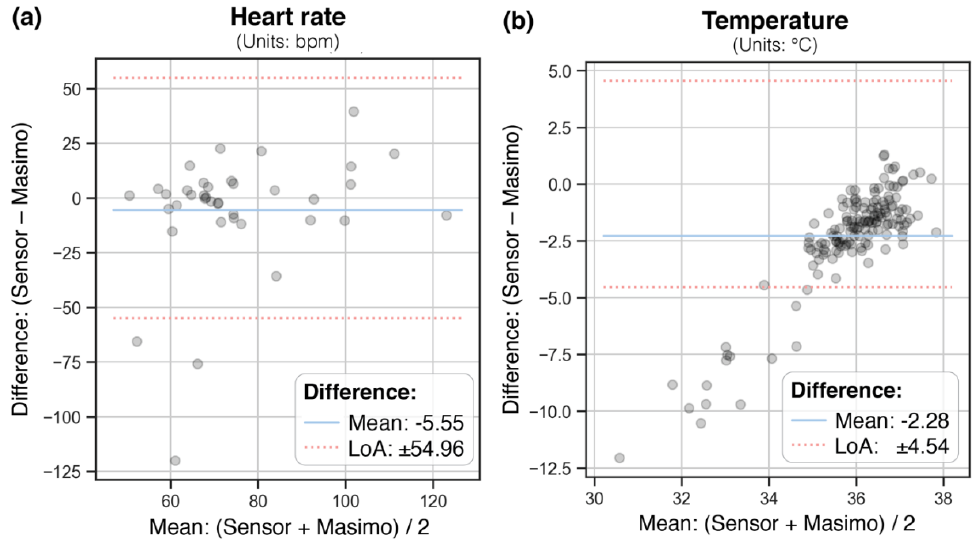
Figure 2. Bland–Altman plots for heart rate ( a ) and body temperature ( b ). The dots represent the measurements by the Everion ® WD (Sensor) vs. conventional measurements (Masimo). Horizontal lines indicate mean difference (center line) and the upper and lower limit of agreement (mean difference ± 1.96 * standard deviation). Abbreviations: bpm, beats per minute; LoA, limits of